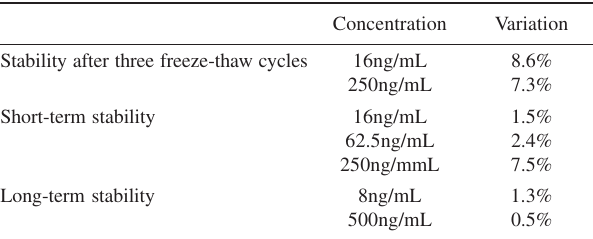
Table 4. Stability studies of propranolol in biological matrices